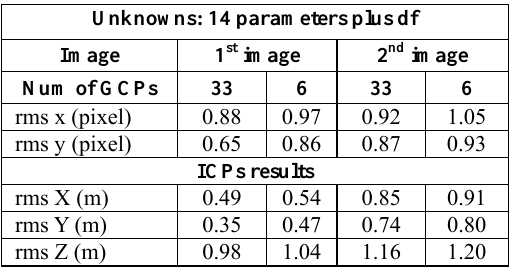
Table 2. Residuals of bundle adjustment with 15 unknown parameters